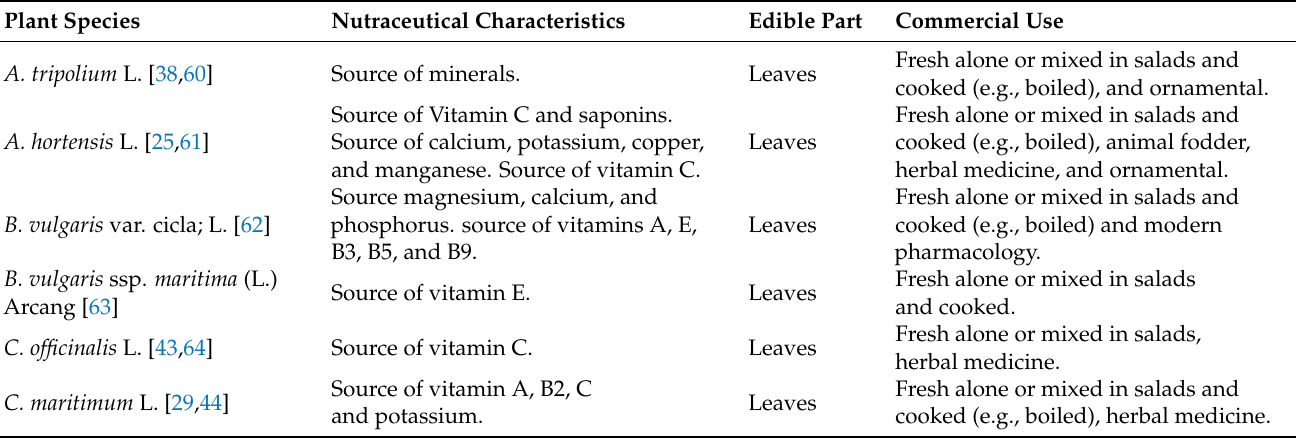
Table 5. Nutraceutical characteristics and main commercial use of the considered plant species. Plant Species Nutraceutical